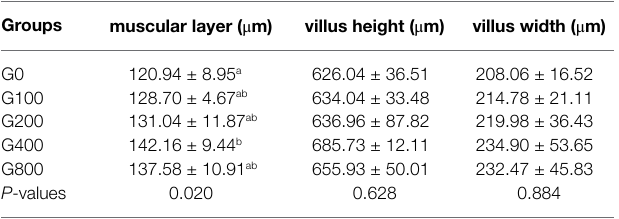
TABLE 6 | Effects of dietary GSH on micro-morphology of the intestine of O. mykiss (mean ± SD, n = 9).